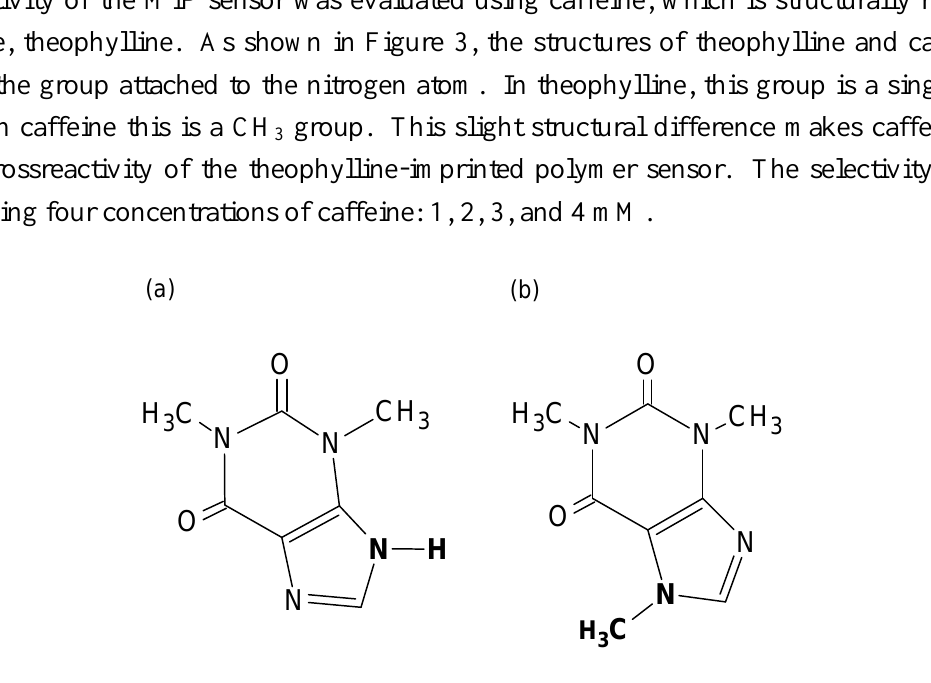
Figure 3. Chemical structures of (a) theophylline and (b) caffeine